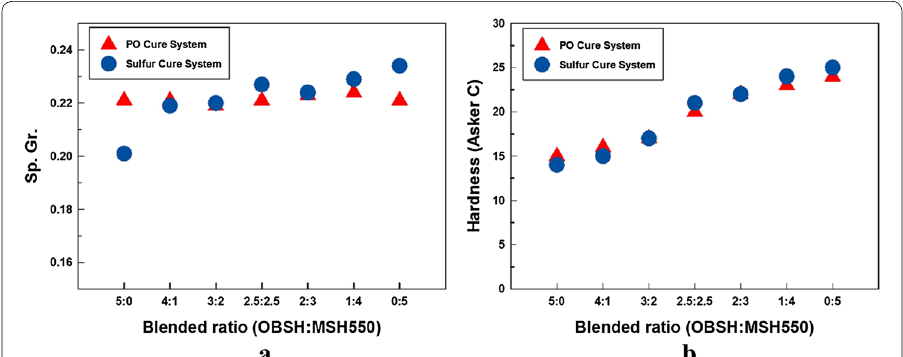
Fig. 4 Specific gravity ( a ) and hardness ( b ) of bio‑EPDM foam depending on the mixing ratio of blowing agents